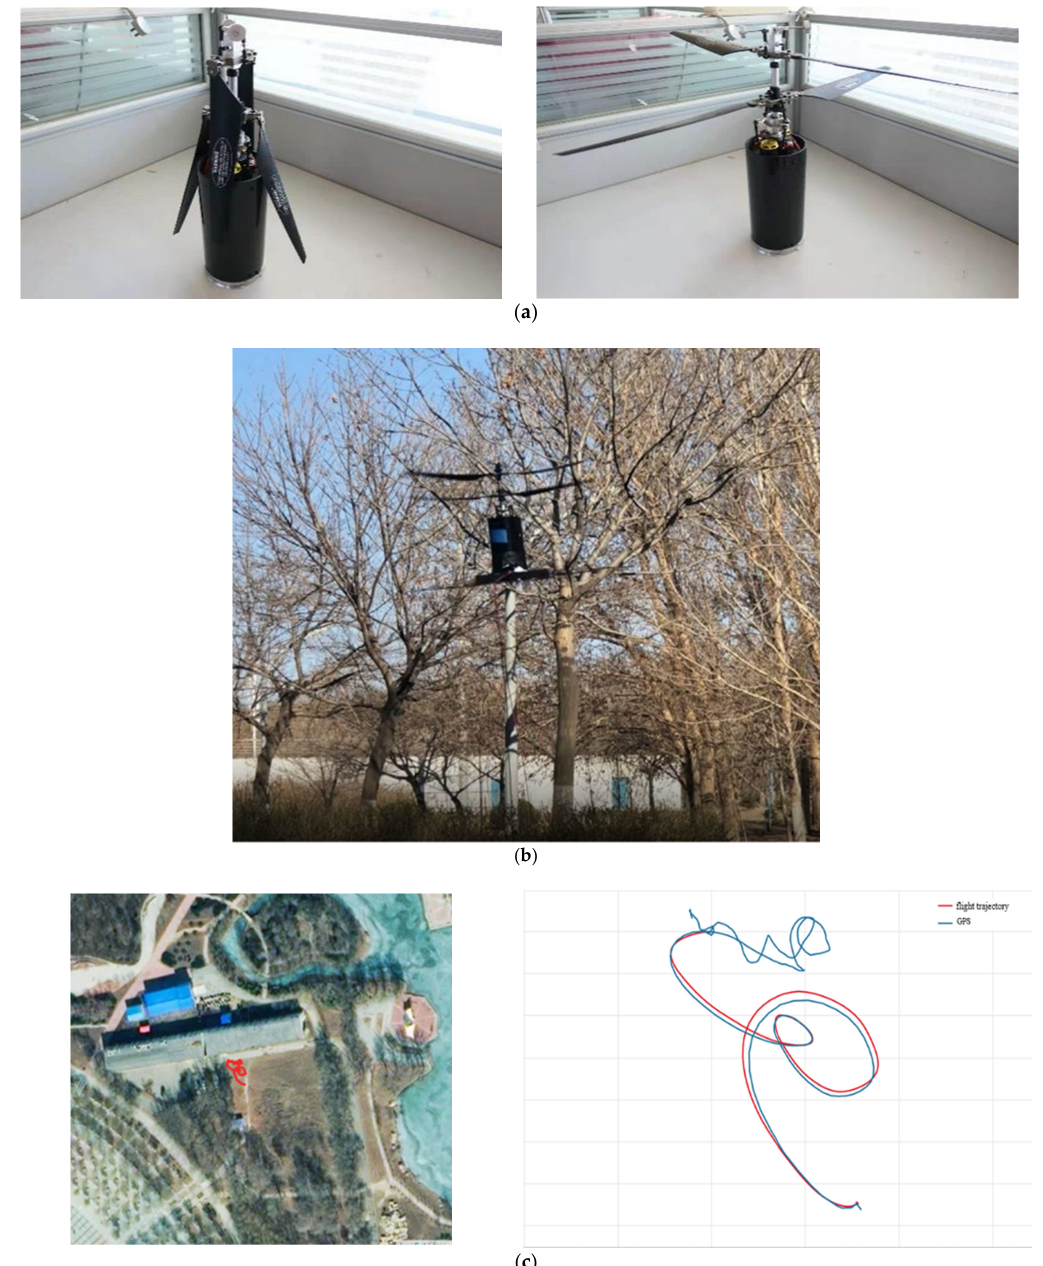
Figure 6. Principal prototype and flight test. ( a ) Principal prototype; ( b ) flight experiment; ( c ) flight trajectory.